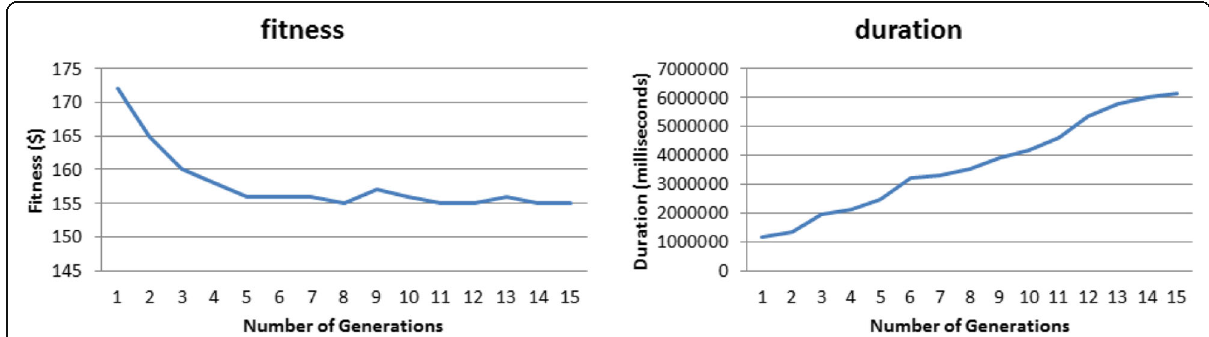
Fig. 6 The number of generation ’ s effect on the fitness value and the experiment